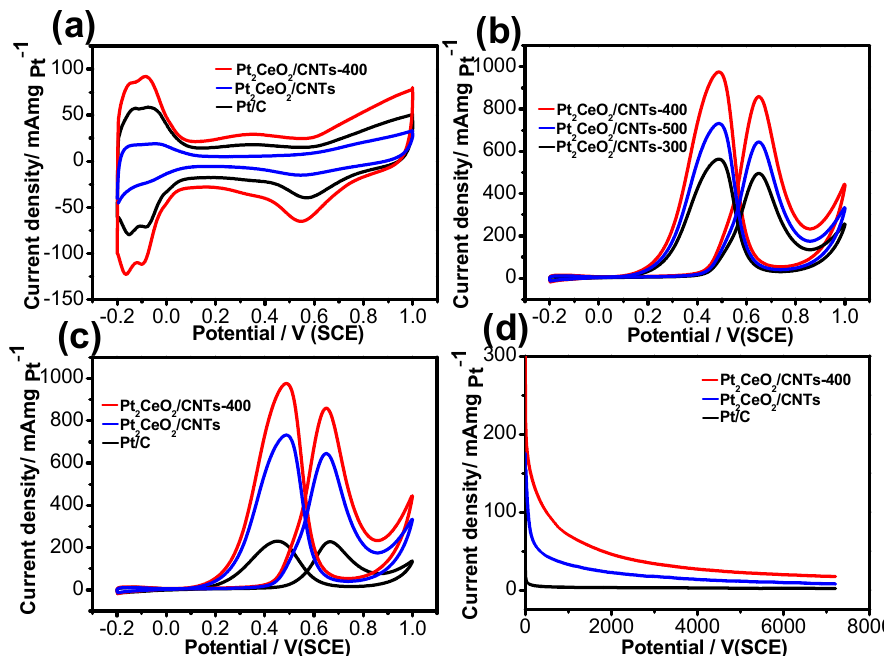
Figure 4. ( a , c ) Cyclic voltammograms and ( d ) current-time curves of Pt 2 CeO 2 /CNTs-400, Pt 2 CeO 2 /CNTs and Pt/C; ( b ) cyclic voltammogram curves of Pt 2 CeO 2 /CNTs-400, Pt 2 CeO 2 /CNTs and Pt/C in 0.5 M H 2 SO 4 /0.5 M CH 3 OH+0.5 M H 2 SO 4 solution.